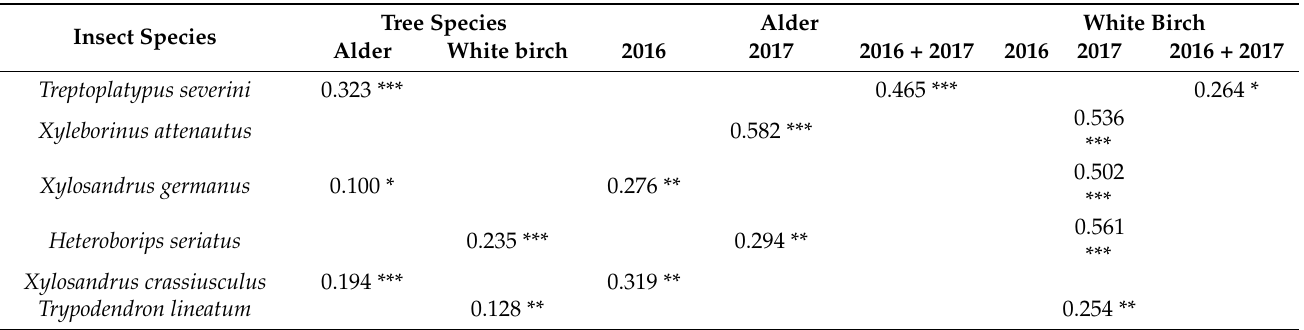
Table 4. Correlation index of the relationship between the beetle species and tree species or sampling year, detected using indicator species